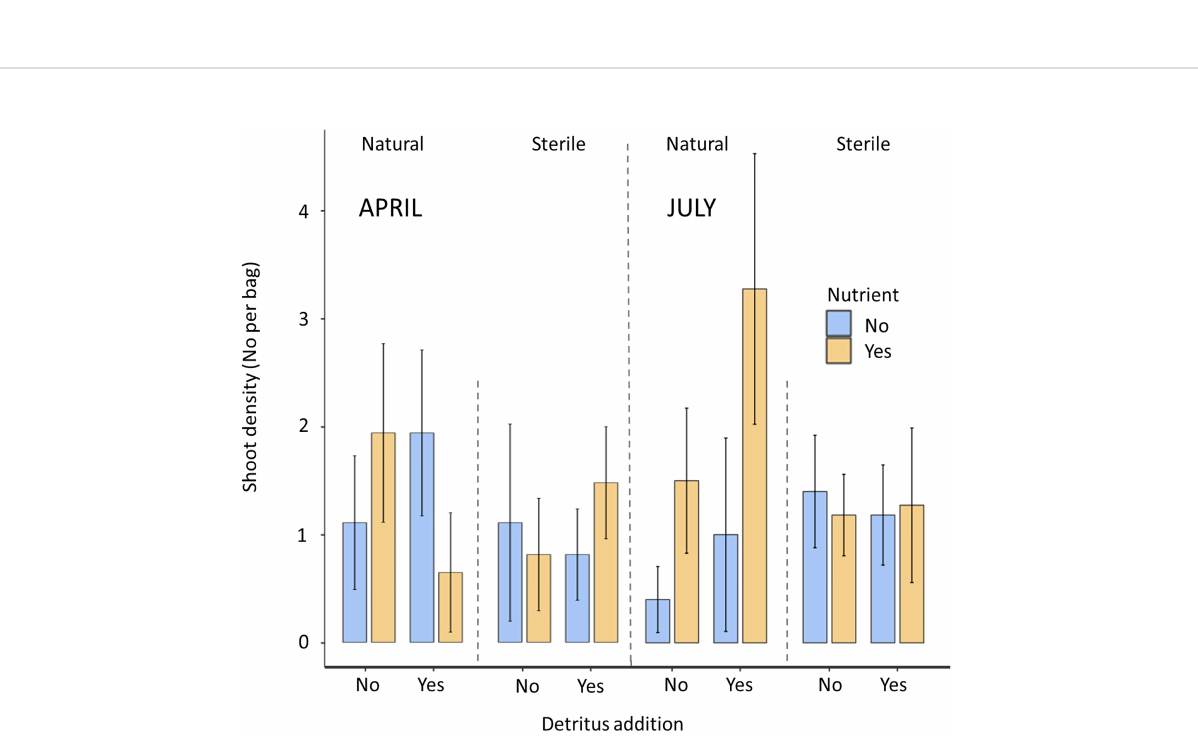
FIGURE 2 Mean ( ± SD) shoot density of the seagrass Zostera marina in hessian bags in Dale, Wales following experimental planting. Seagrass seeds were planted into hessian bags according to a factorial design of three treatments (sediment type, detritus addition, nutrient addition).